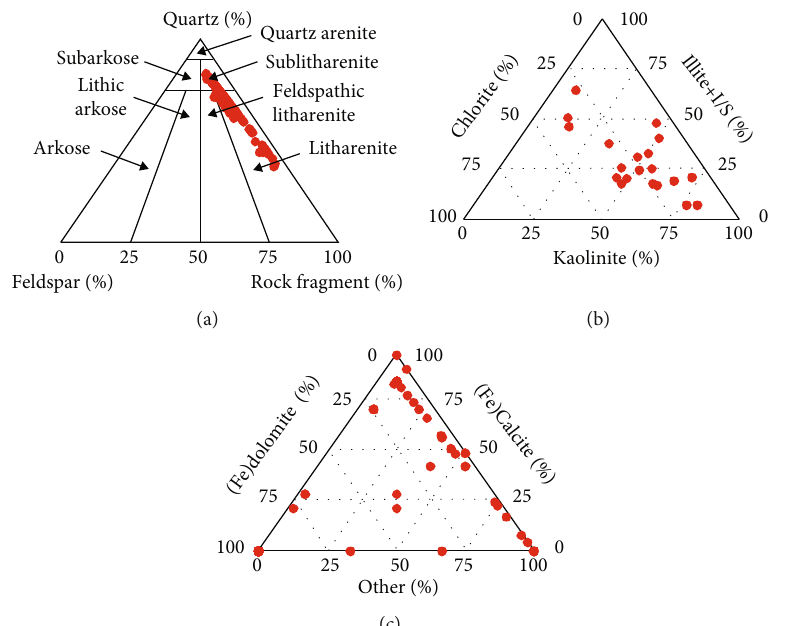
Figure 2: Ternary diagrams of the (a) detrital grain content, (b) bulk clay composition, and (c) bulk carbonate constitution of H8 tight